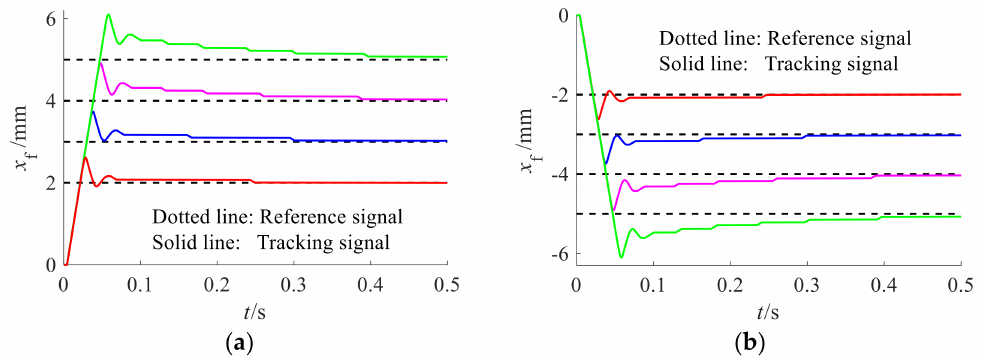
Figure 8. Step response of the fuel metering valve: ( a ) Positive movement; ( b ) Negative movement.